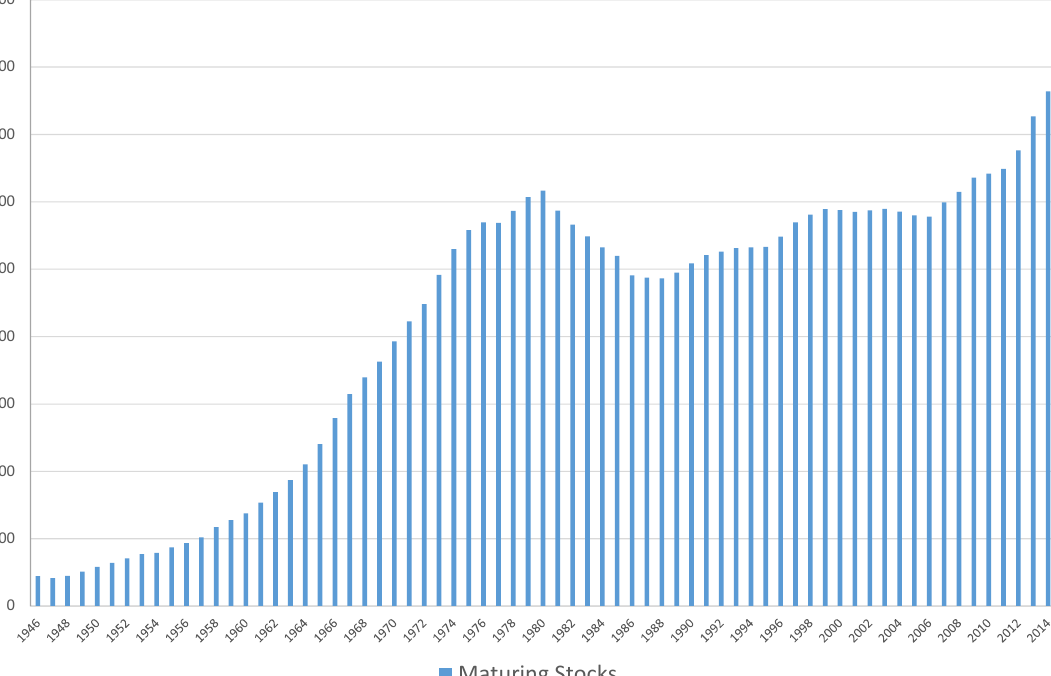
Figure 6. Maturing whisky stocks. Year-end figures for the aggregate of malt and grain stocks (in mlpa). Constructed from SWA statistics and The making of Scotch whisky as outlined above.